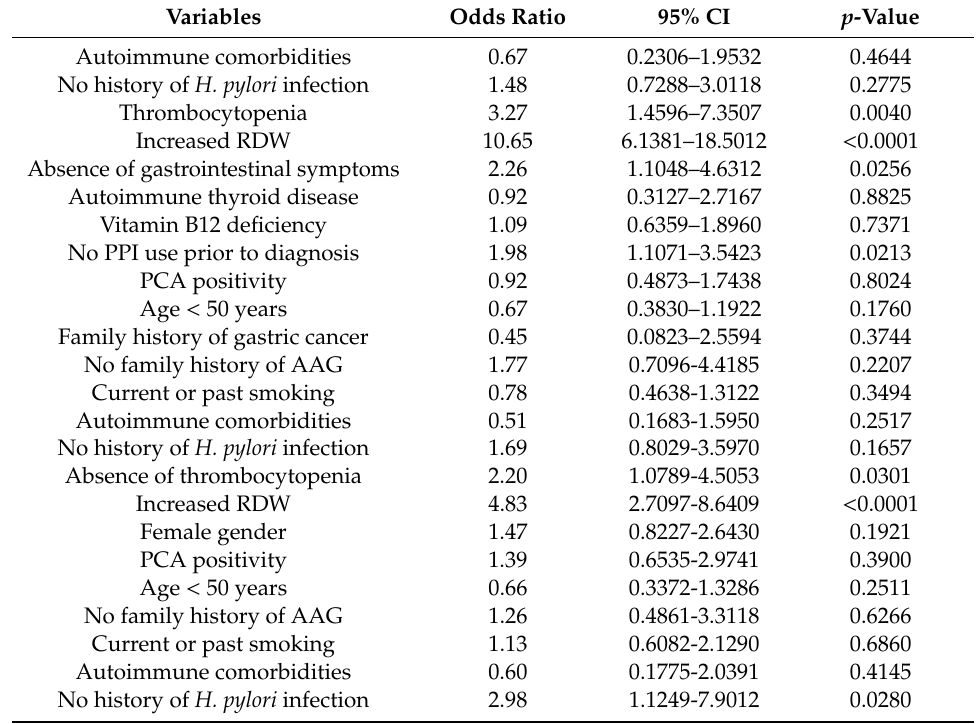
Table 4. Multivariate logistic regression analysis for variables associated with anaemia (any type), iron deficiency anaemia, and pernicious anaemia in patients with autoimmune atrophic gastritis (AAG).